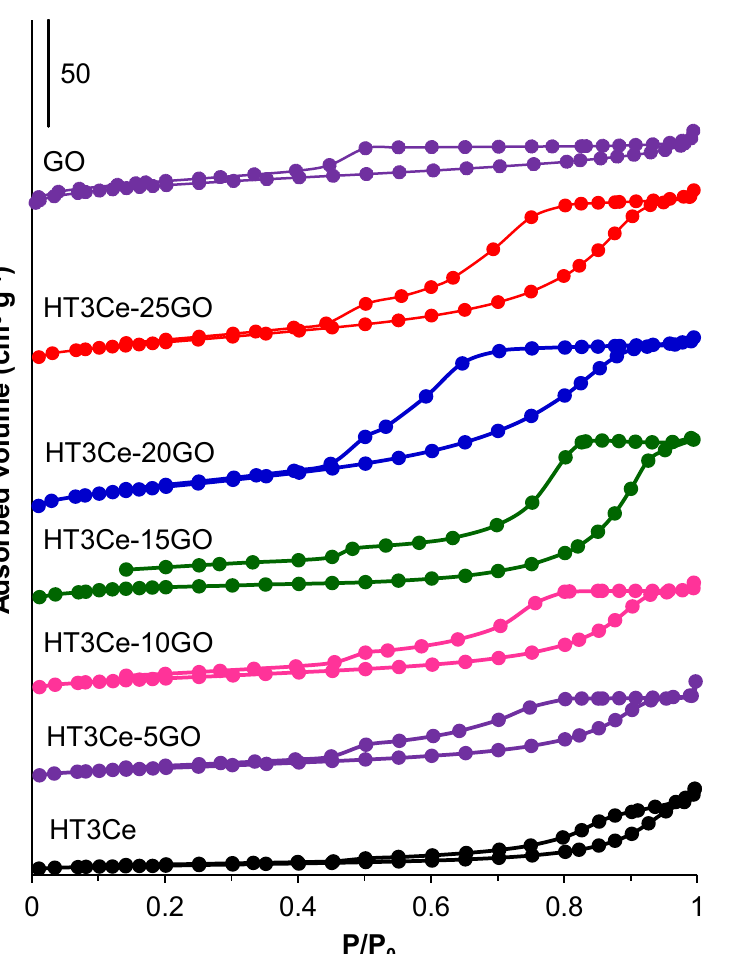
Figure 1. Nitrogen adsorption-desorption isotherms for HT3Ce LDH, GO, and HT3Ce-xGO sam- ples.